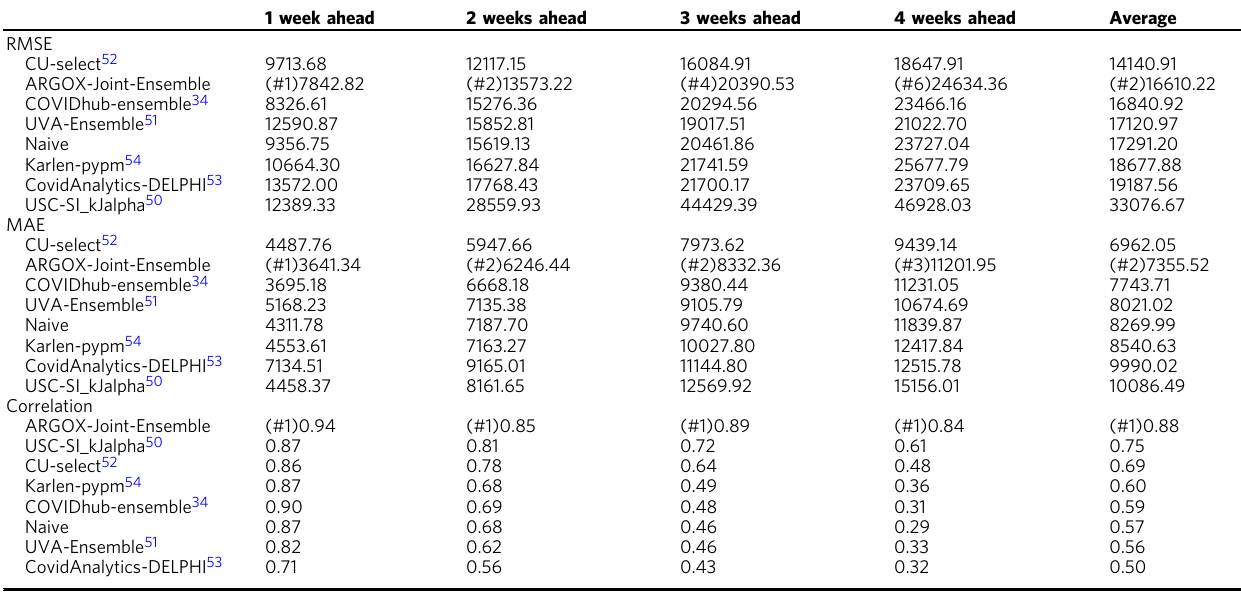
Table 4 Comparison among different models ’ 1 to 4 weeks ahead U.S. states level weekly cases predictions (from 2020-07-04 to 2022-08-13).